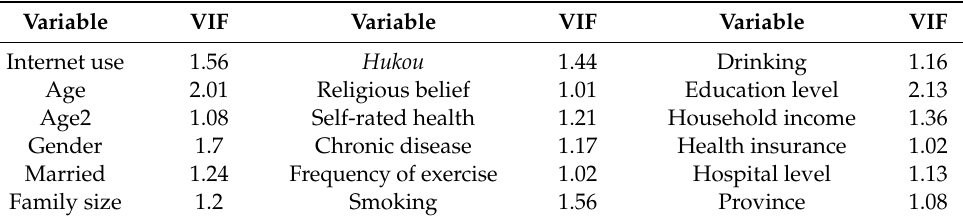
Figure A2. Changes of Internet users and Internet penetration rate. Table A1. Multiple collinearity test.